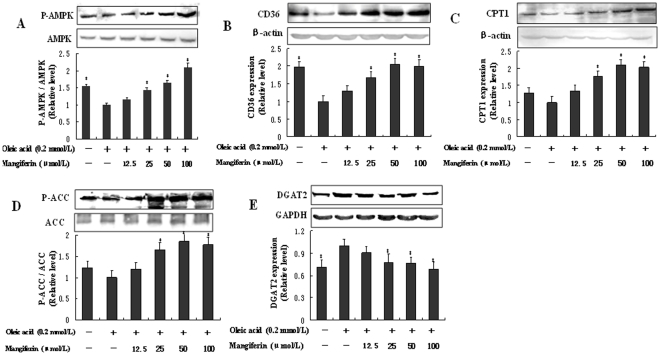
HepG2 cells were incubated with 0.2 mmol/L OA only or with different concentrations of mangiferin (12.5, 25, 50, 100 µmol/L) simultaneously for 24 h.Proteins were isolated from the cell lysates and analyzed by western blot analysis for AMPK (A), CD36 (B), CPT1 (C), ACC (D) and DGAT (E) expressions. The experiments were repeated 3 times. Data are presented as means ± SD (n = 3). *
P<0.05 compared with only OA stimulation group.